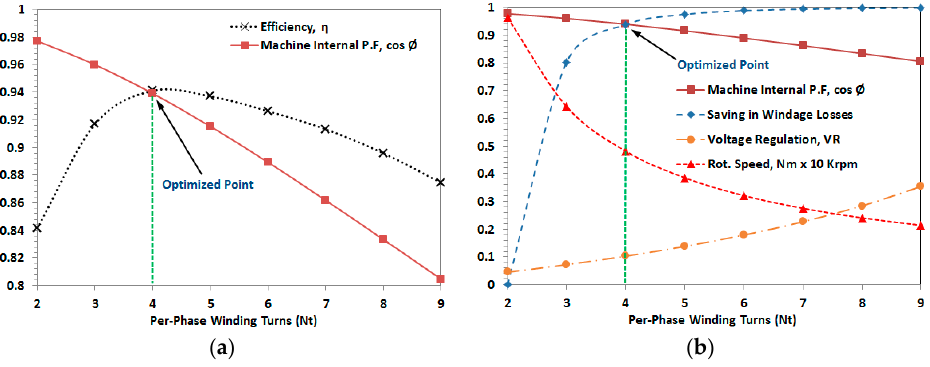
Figure 5. Optimization results for the AFPMA: ( a ) Machine efficiency and the internal power factor vs. number of turns; ( b ) Saving in windage losses, voltage regulation, and rotational speed vs. number of turns. Table 2. AFPMA Set